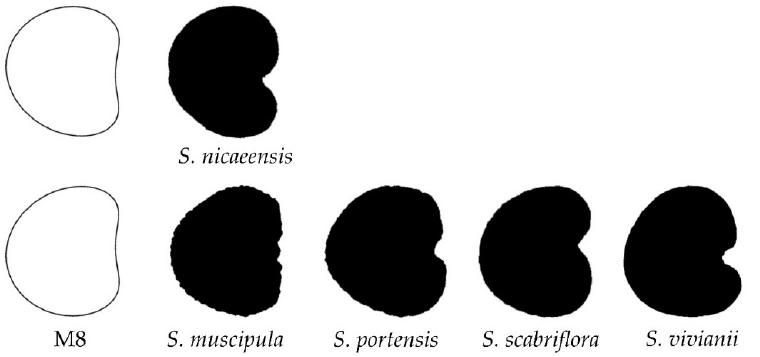
Figure 9. Seed silhouettes of Silene species resembling the geometric model M8. The typical asym- metric figure of this model is observable on the opposite area of the hilum, as exposed on the two lines of seeds.